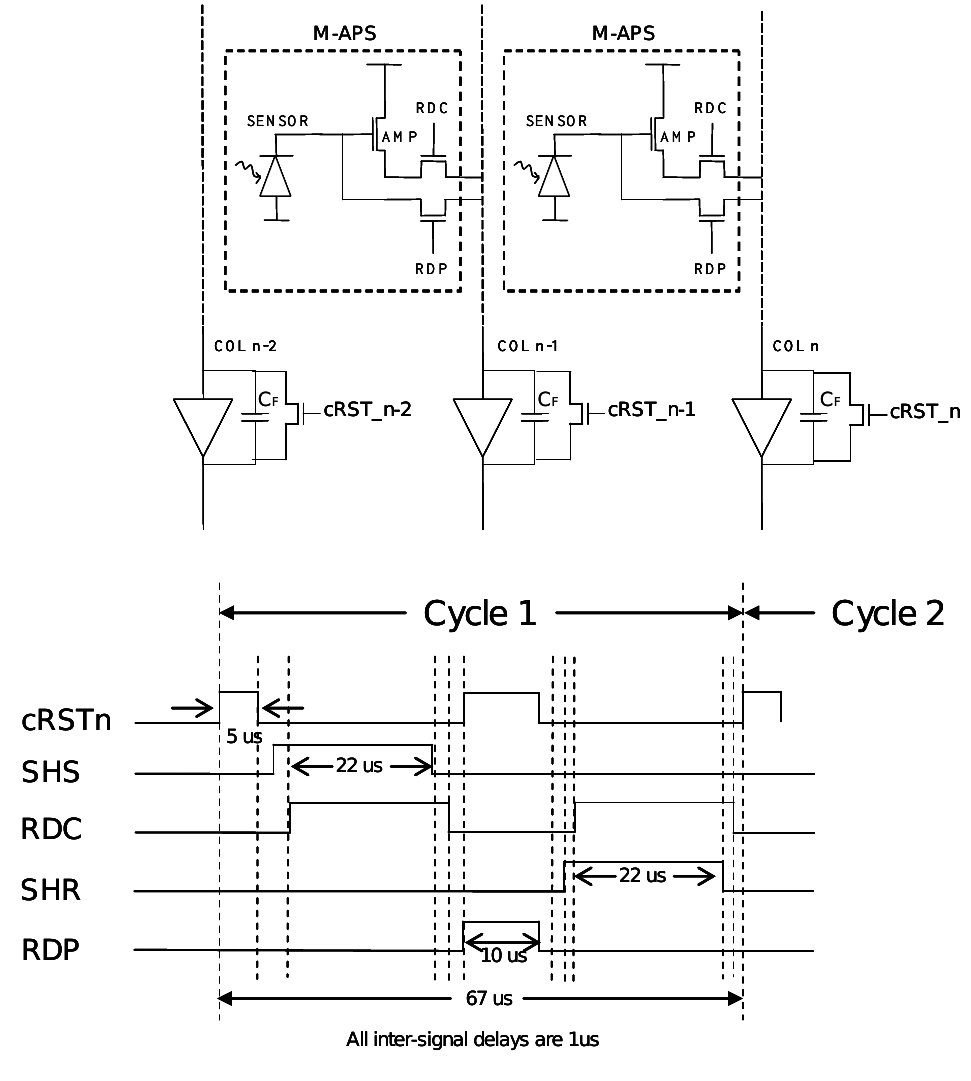
Figure 17. Three transistor APS pixel circuit and the timing